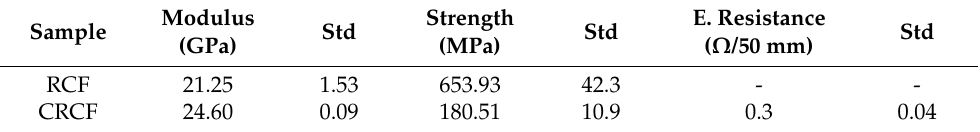
Table 2. Properties of the tested tows before and after treatment. Values were the average of 5 specimens. Std stands for “standard deviation”, E. Resistance is the “Electrical